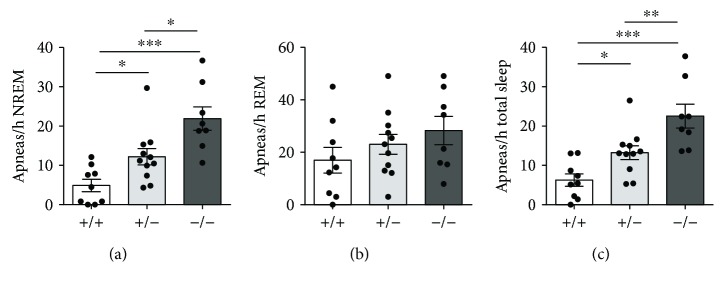
Sleep apnea occurrence rate in Cdkl5 +/− female mice. (a, c) Apnea occurrence rate during NREM sleep (a), REM sleep (b), and total sleep period (c). Cdkl5 +/− (n = 11) and Cdkl5 −/− (n = 8) mice showed an increased number of apneas during NREM sleep (a) and, consequently, an increased number of total sleep apneas (c) compared to Cdkl5 +/+ (n = 9) mice. Values represent mean ± SEM. ∗
p < 0.05, ∗∗
p < 0.01, and ∗∗∗
p < 0.001 (Fisher's LSD test after ANOVA).